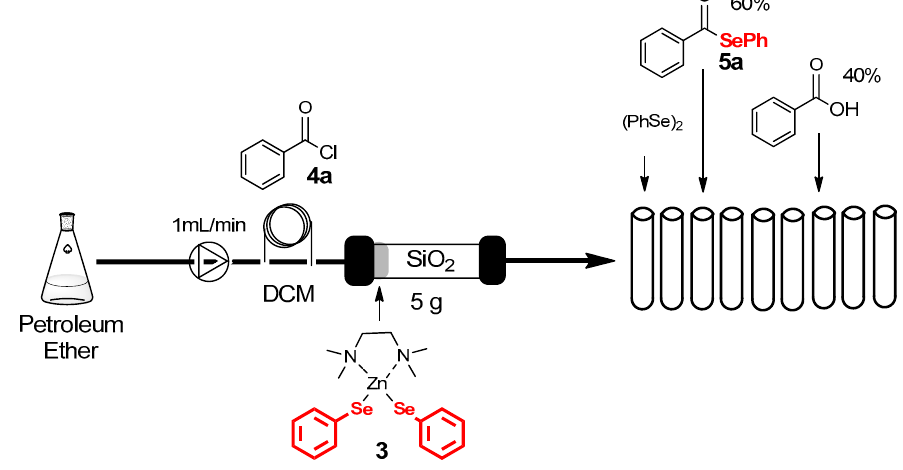
Figure 4. One-pot synthesis and chromatographic purification of the selenol ester 5a .